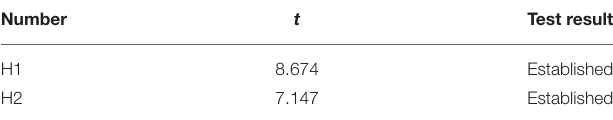
TABLE 1 | Hypothesis test